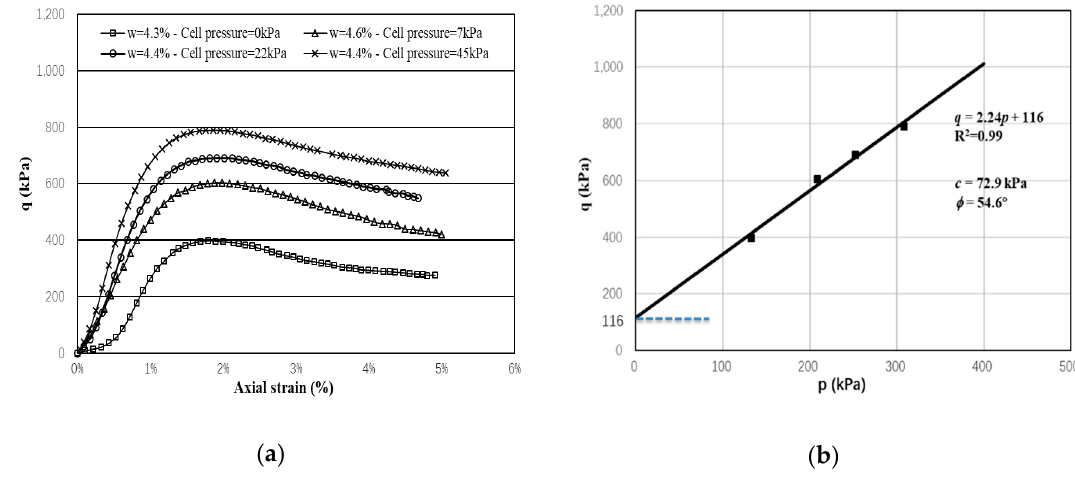
Figure 7. Monotonic test results ( w = 4.4%): ( a ) q – ε 1 curve; ( b ) strength parameters and rupture line. The mean normal stress p and deviator stress q are defined by.